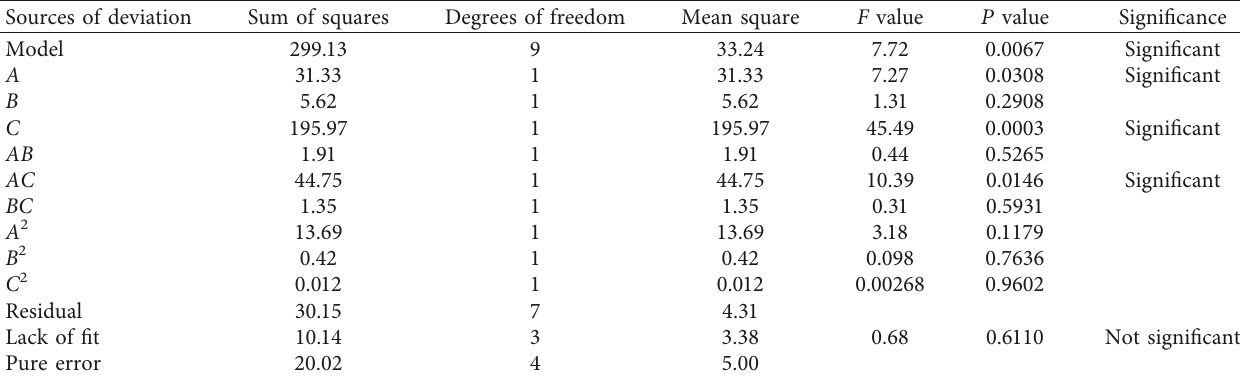
Table 3: Regression equation coefficient